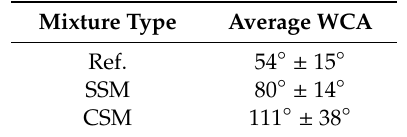
Table 1. Average WCA values for each cement-based mixture .